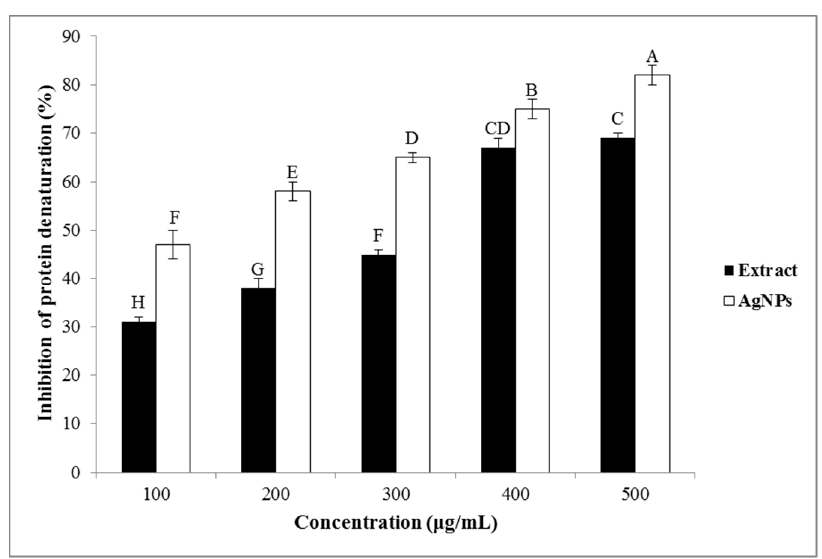
Figure 7. The anti-inflammatory effect of the A. tribuloides root extract and the greenly synthesized AgNPs. Various letters represent significant differences ( p < 0.05) based on the Duncan’s test.